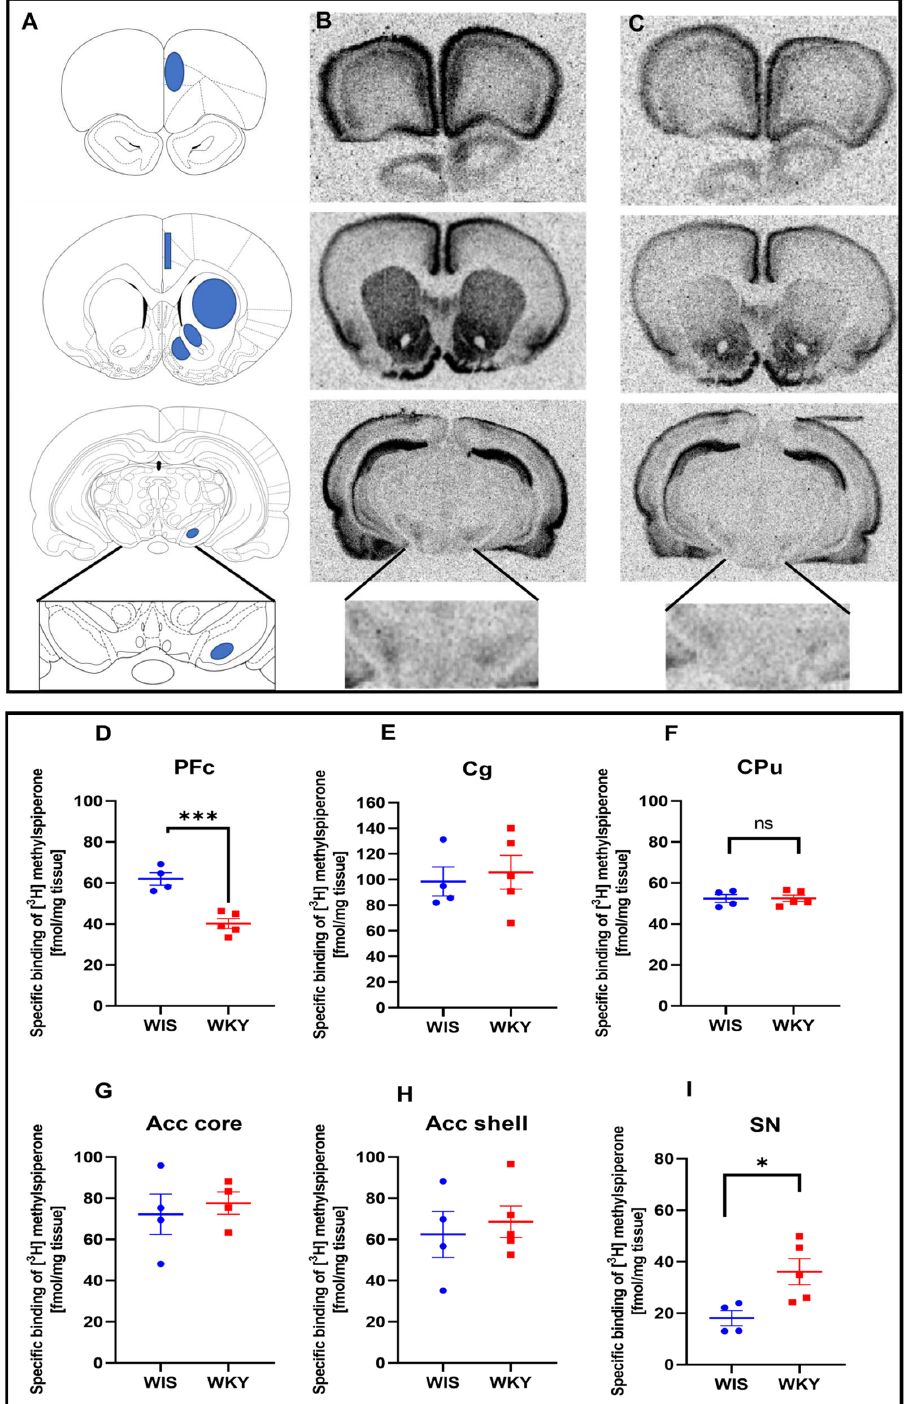
Figure 1. Example autoradiograms of the marked brain areas for which analysis was performed. ( A ) The brain areas were selected for quantitative autoradiography, based on the Rat Brain Atlas [25]. Areas marked in blue were quantified and then converted to fmol/mg tissue. ( B ) The total [ 3 H] methyspieperone binding; ( C ) the non-specific binding; ( D ) the decrease in binding in the prefrontal cortex (PFc) (* p < 0.05; *** p < 0.001 WKY (red points) vs. WIS (blue points)); ( E ) no change in the cingulate cortex (Cg); ( F ) no change (ns) in the caudate putamen (CPu); ( G ) no change in the accumbens core ( H ); no change in the accumbens shell; and ( I ) increase in the binding in the substantia nigra (WKY vs. WIS p < 0.05, n =